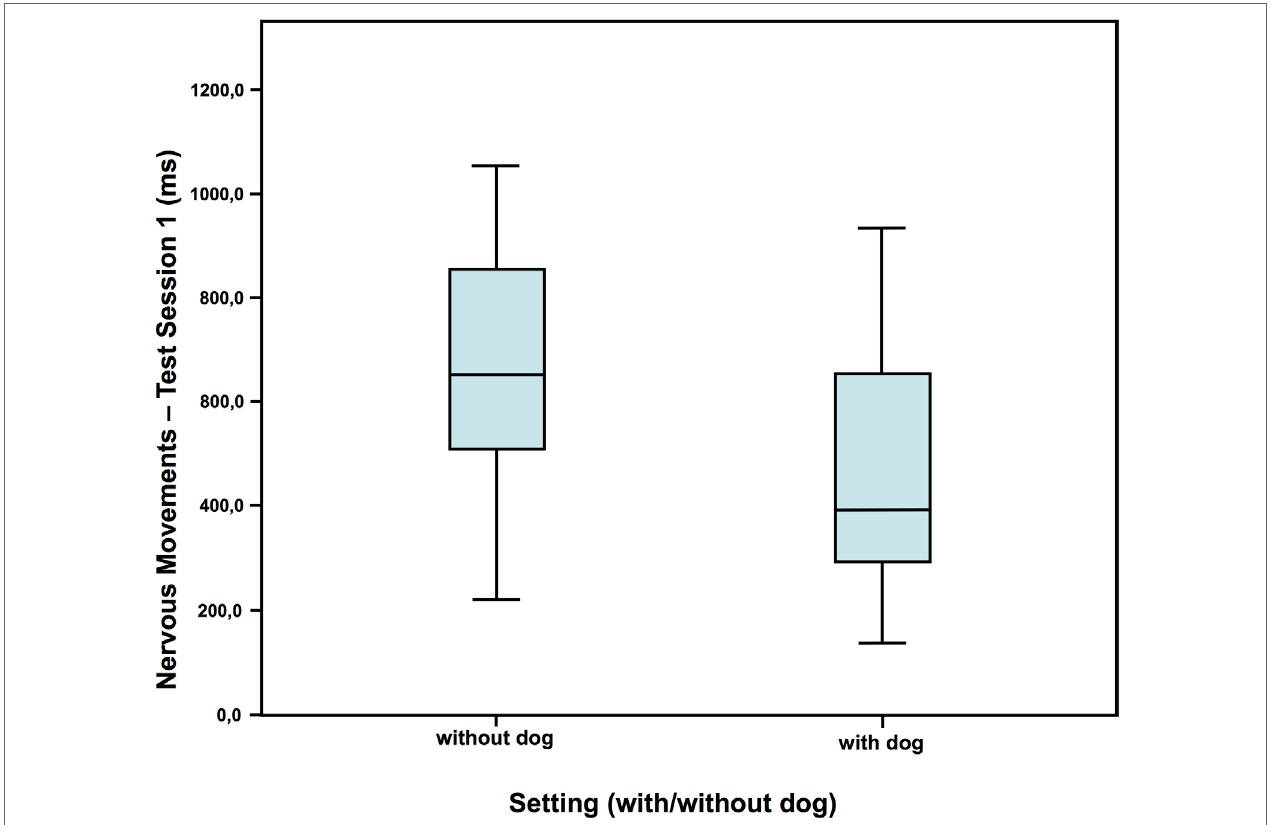
FigUre 3 | Duration of nervous movements in test session 1—comparison of the two settings